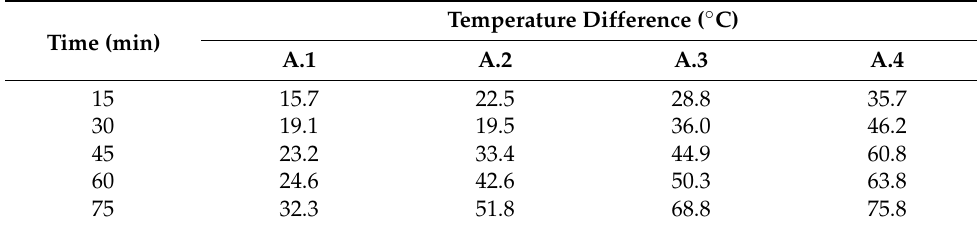
Table 4. The temperature difference between the surface of SUS304 and the coating surface of A.